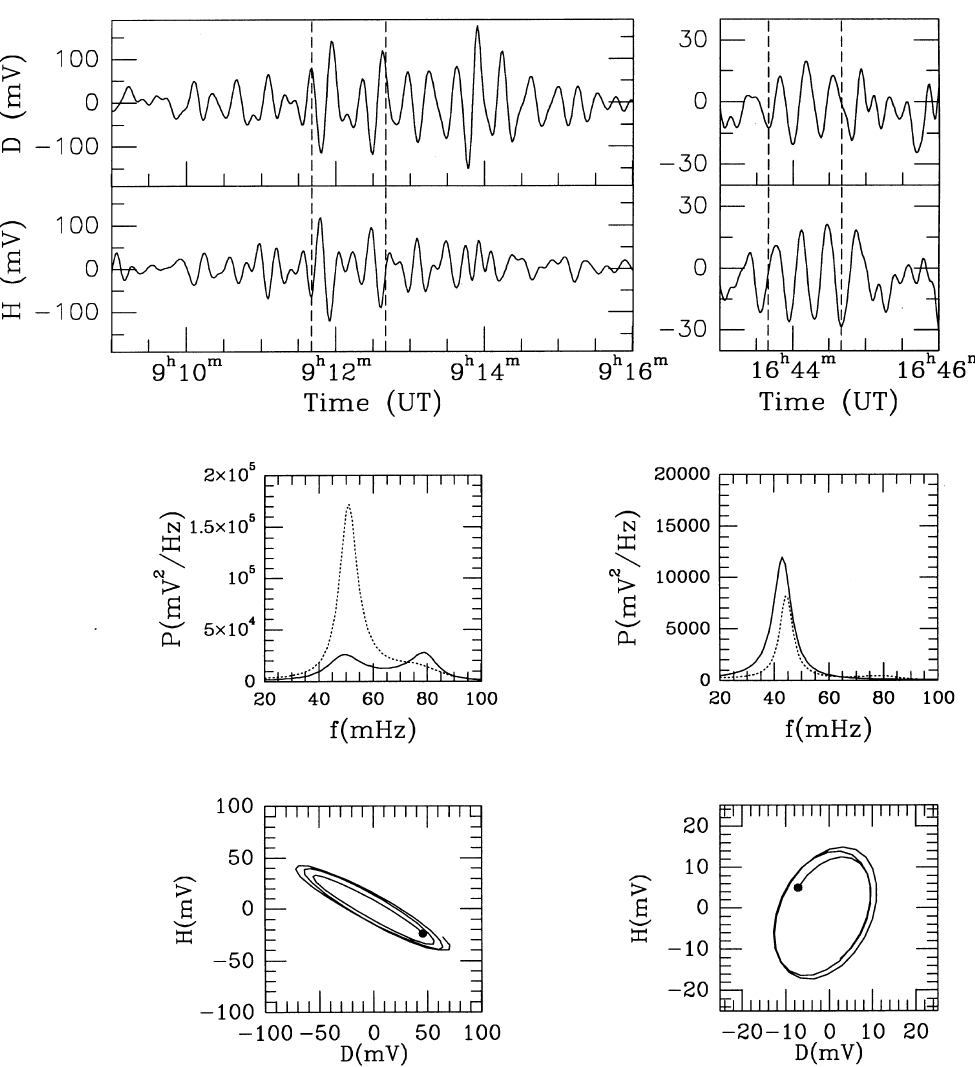
Fig. 5. Low-pass filtered (0–100 mHz) H and D data at AQ in the time intervals 0909–0916 UT ( left ) and 1643–1646 UT ( right ), together with the corresponding power spectra (H, solid line) and the hodograms for two selected wave packets (indicated in the